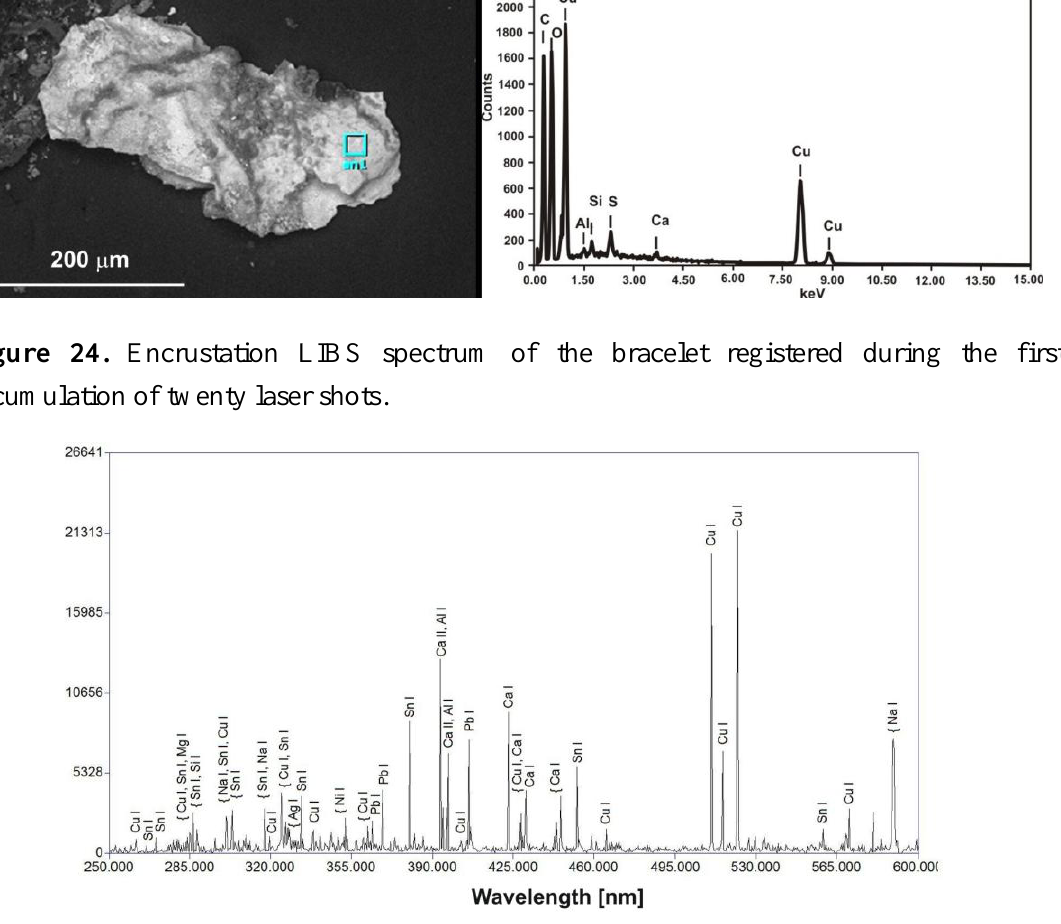
(OH) CO (upper plot) 2 2 3